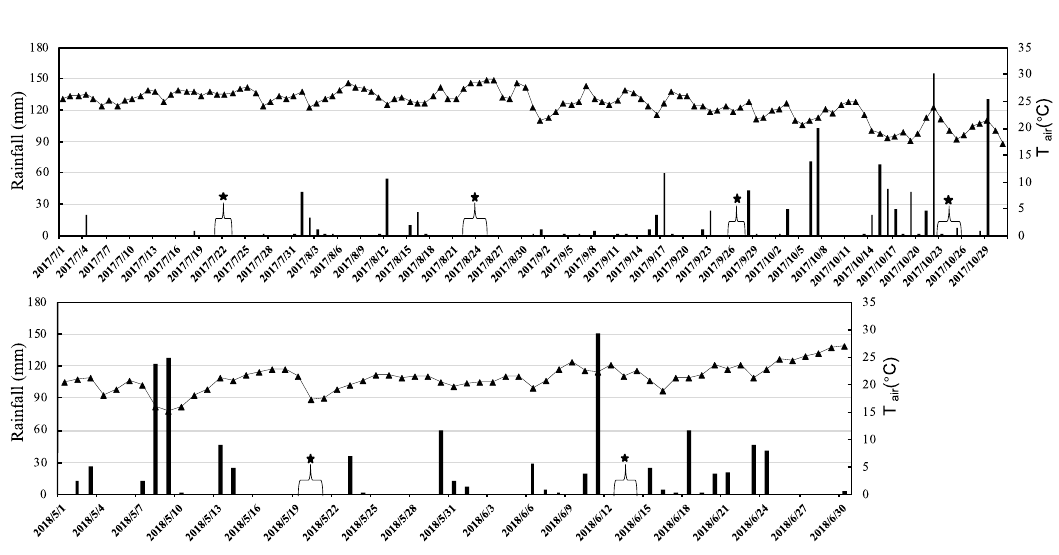
Figure A2. Landscape of bare land ( a ) and shrub land gap ( b ), shrub land under canopy ( c ).